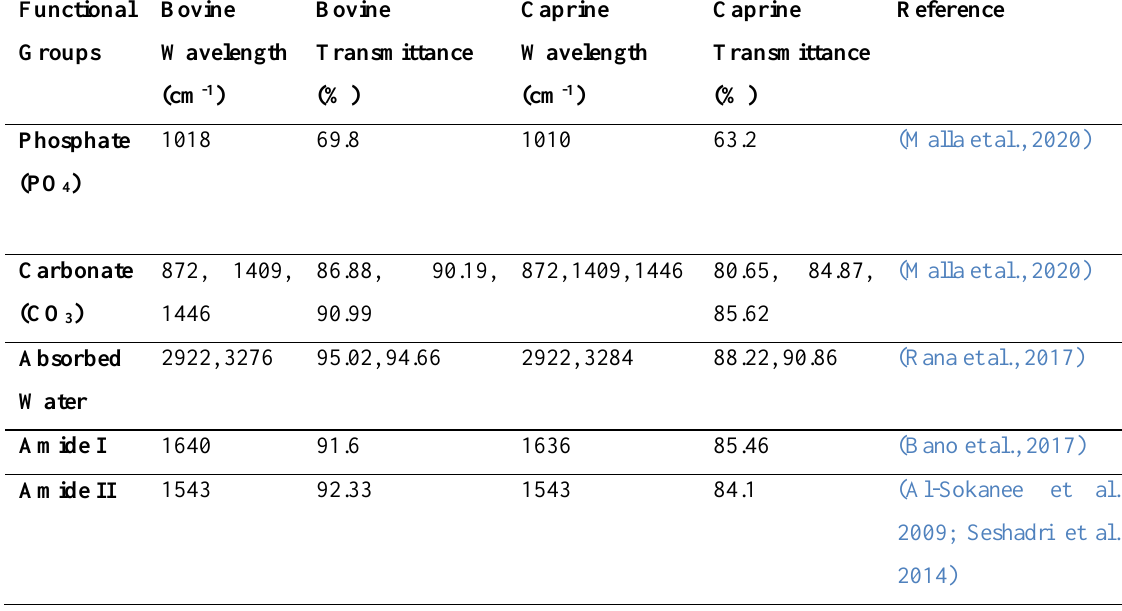
Table 2. FTIR Peaks of bovine and caprine bone